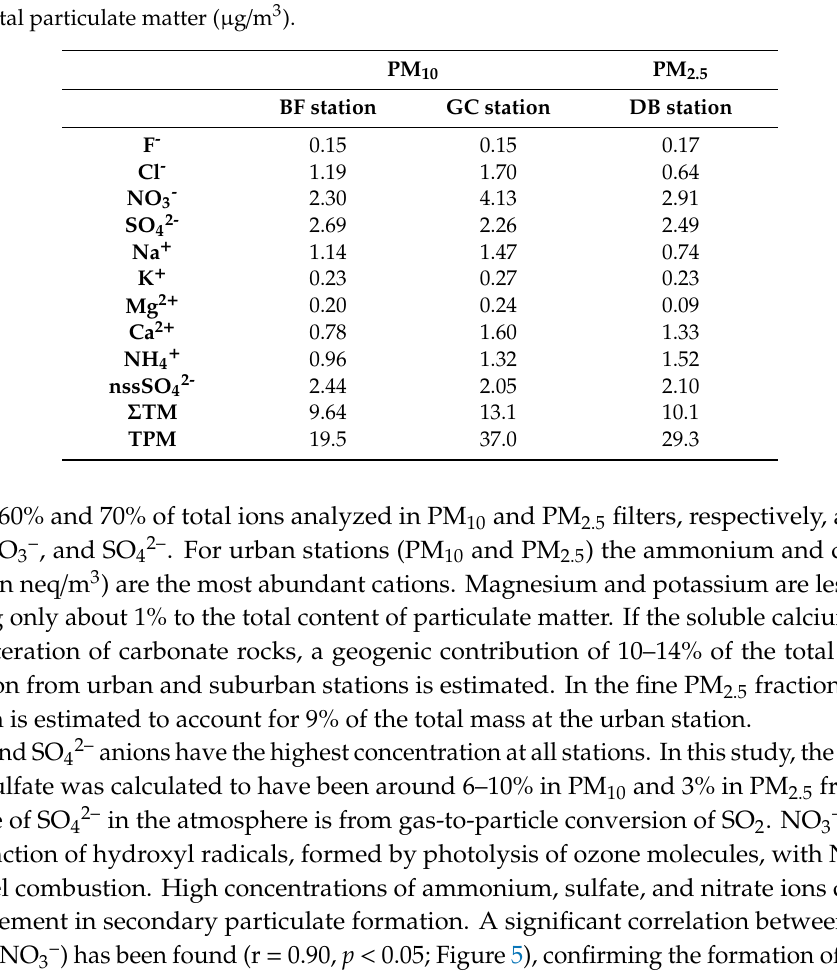
(cid:80) TP, total mass of ions;